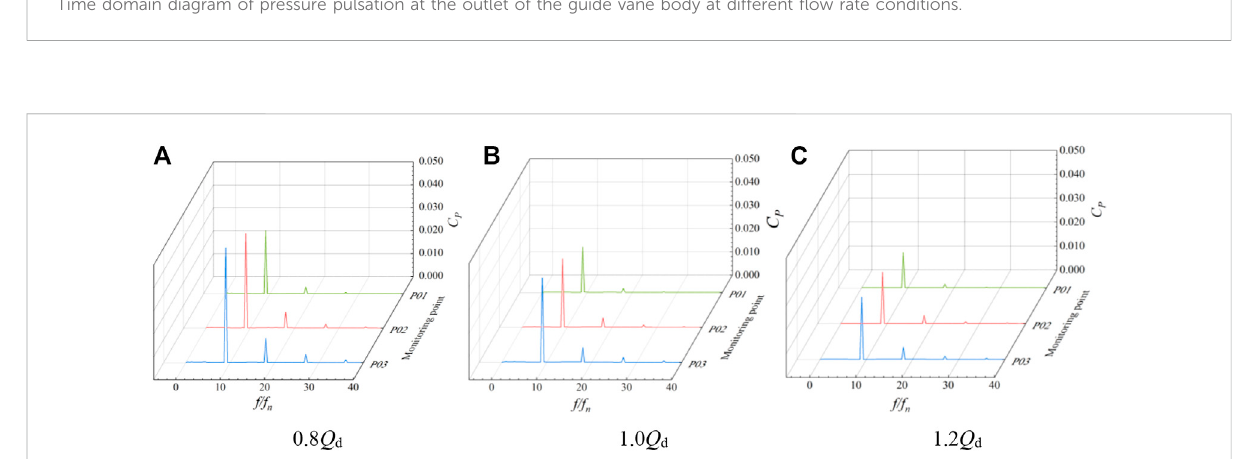
FIGURE 15 Time domain diagram of pressure pulsation at the outlet of the guide vane body at different fl ow rate conditions.